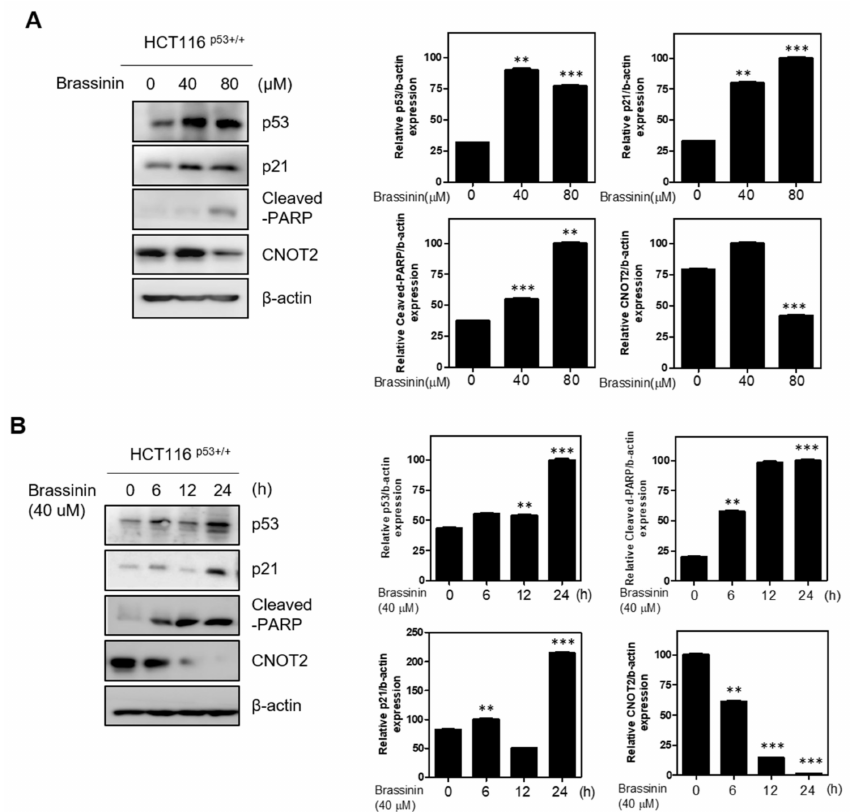
Figure 1. Brassinin induces p53 dose- and time-dependently. ( A ) HCT116 p53+/+ cells were treated with Brassinin (0, 40, 80 µ M). p53, p21, cleaved-PARP, and CNOT2 were determined by western blotting. ( B ) HCT116 p53+/+ cells were treated with Brassinin (40 µ M) for 0, 6, 12, and 24 h. Data represent means ± SD. * p < 0.05, ** p < 0.01, *** p < 0.001 vs. control. Values of Western blotting images represent relative level of protein expression/ β